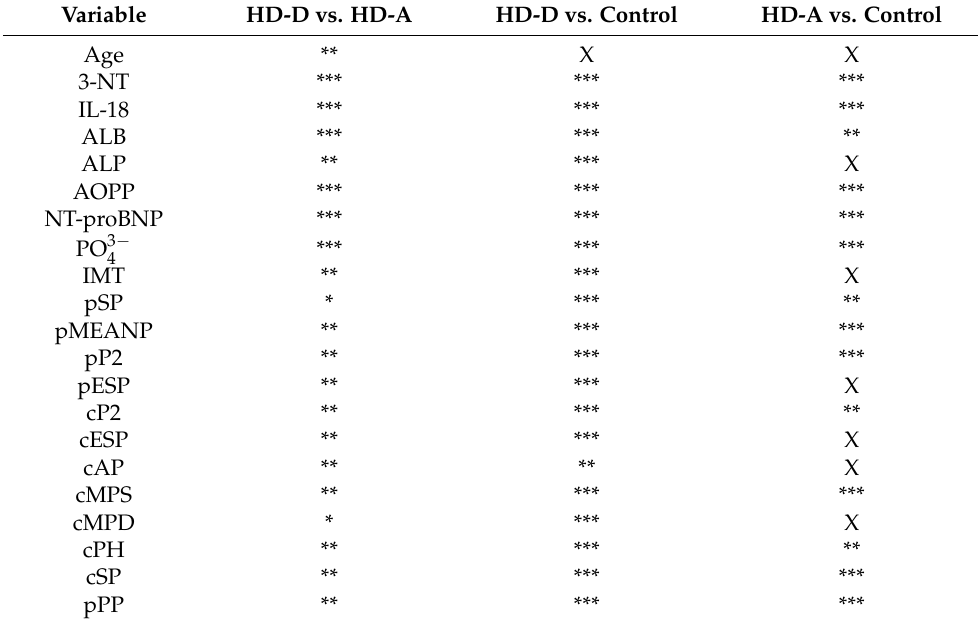
Table 3. Significant differences for HD-A vs. HD-D (calculated Kruskal–Wallis H > H critical ( 5.991 ) ), with additional comparison to existing (or not) dissimilarities to the control group (HD-D vs. Control and HD-A vs. Control). Significance of differences found has been marked in following